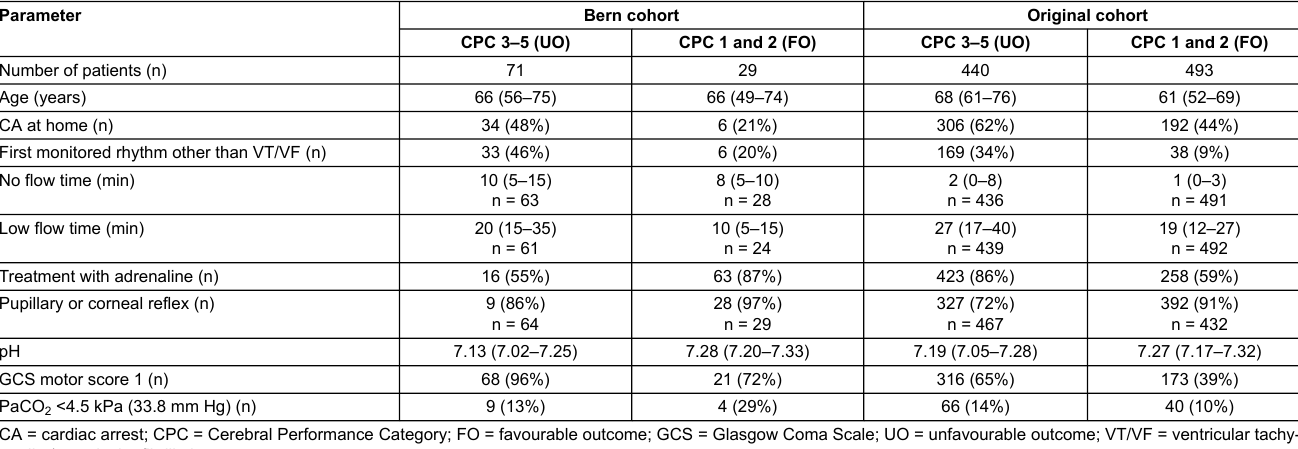
Table 1: The 10 patient characteristics and circumstantial factors related to outcome. Parameter